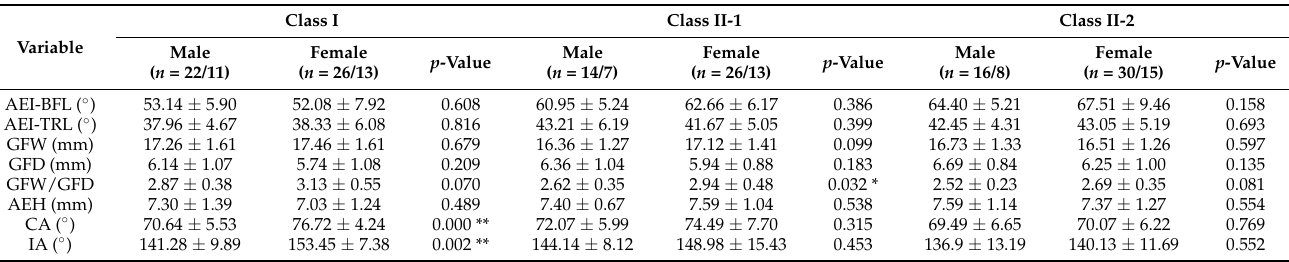
Table 5. Descriptive statistics of the measurements of the temporomandibular joint according to gender among the three malocclusion groups.